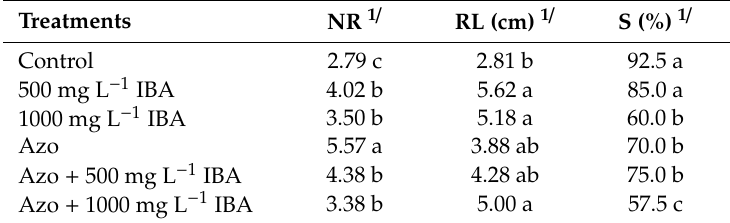
Table 2. Number of roots (NR), root length (RL), and sprouting (S) of ‘Powderblue’ blueberry cuttings treated with indolebutyric acid (IBA) and Azospirillum brasilense